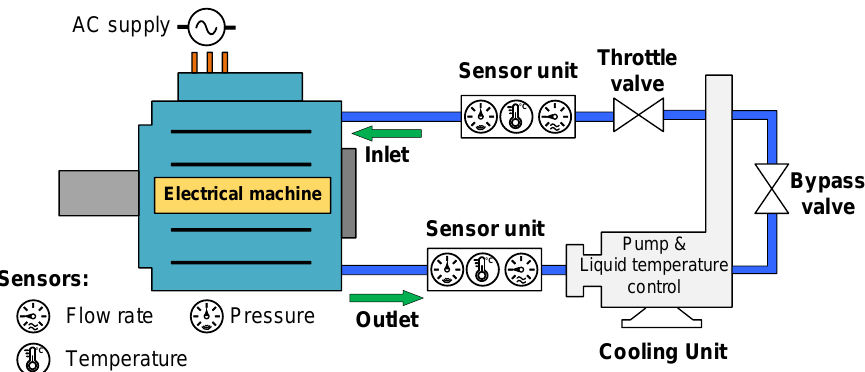
Figure 9. Schematic diagram of forced liquid cooling system of electrical machines with associated apparatus.